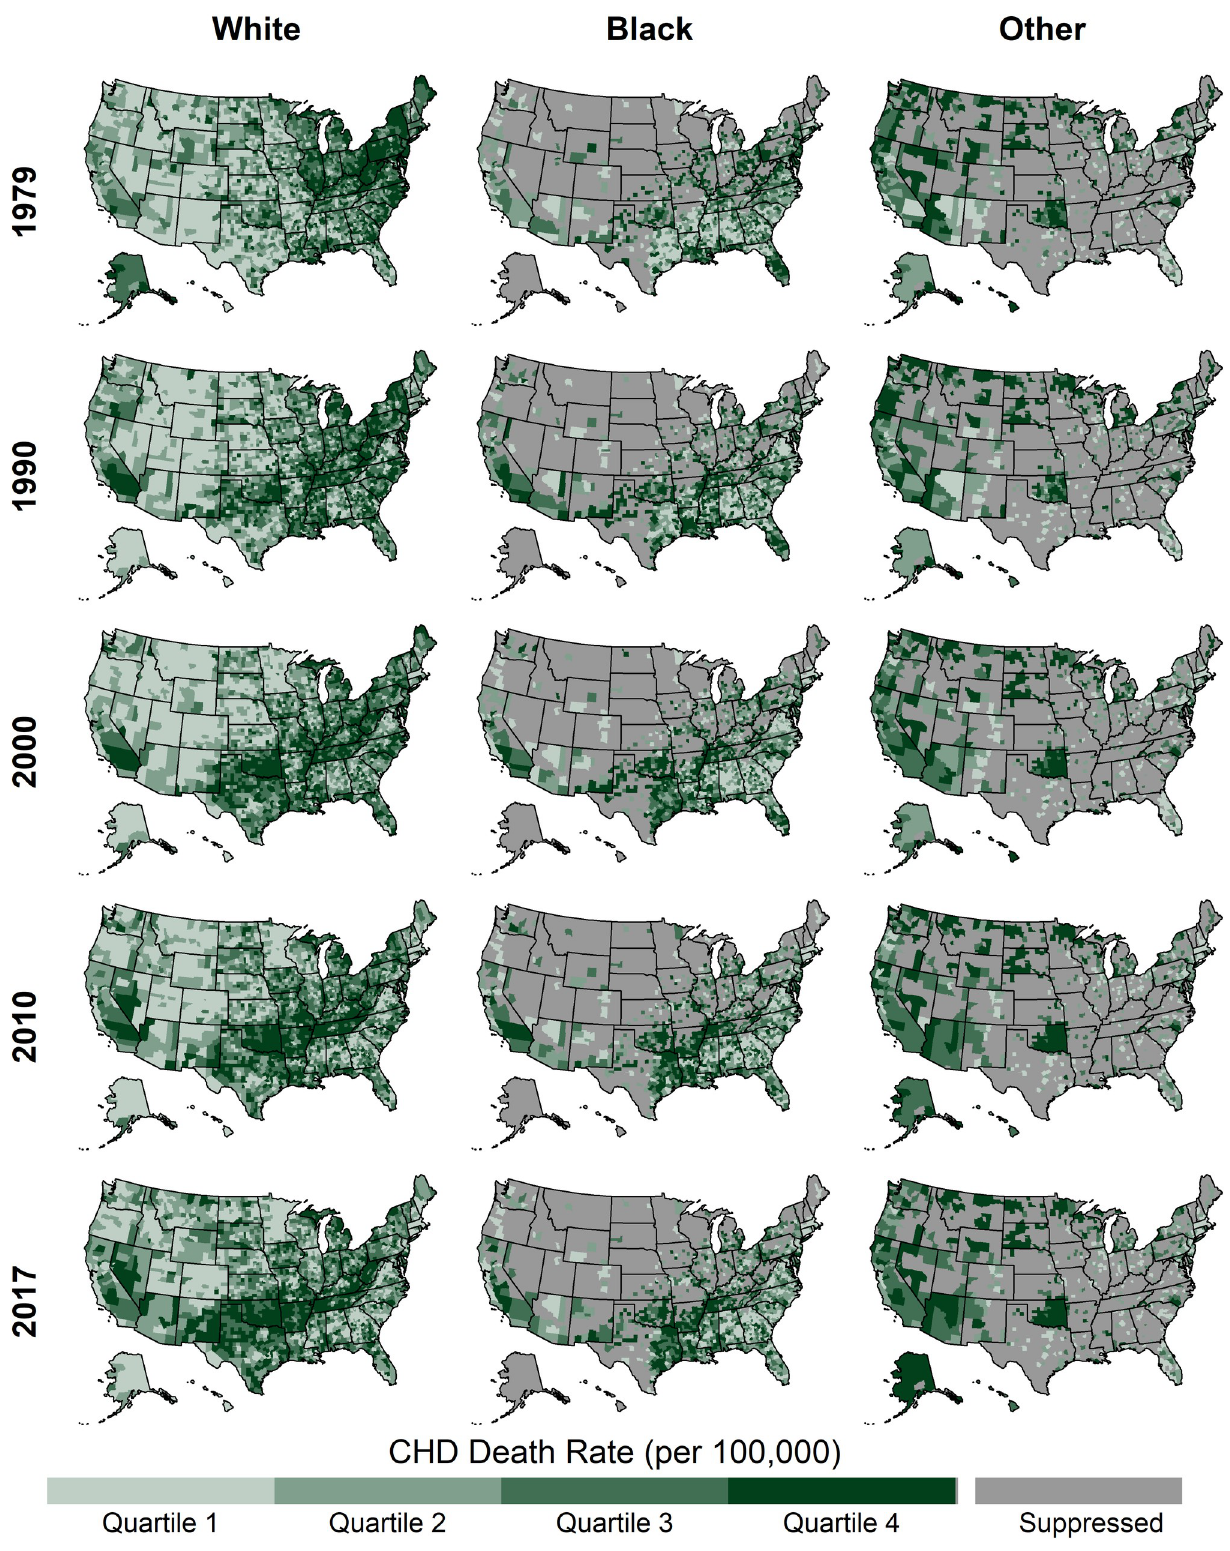
Fig 6. County-level CHD death rates by year and race, ages 35 and older, United States, 1979–2017. Quartile ranges are shown in Table 2.